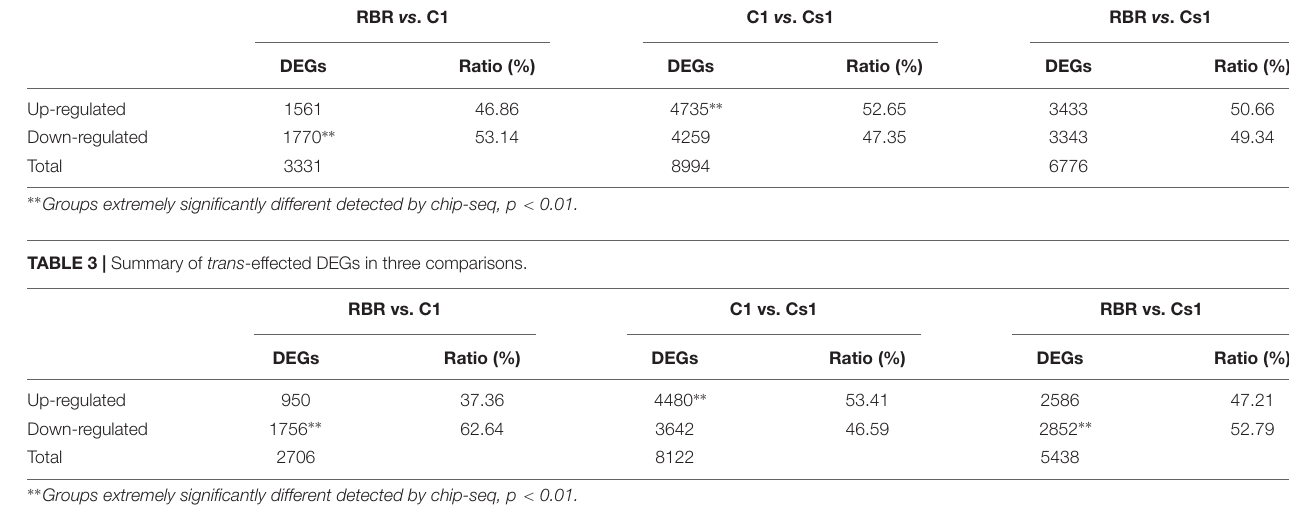
TABLE 2 | Proportion of up- and down-regulated differentially expressed genes (DEGs) in three comparisons. RBR vs . C1